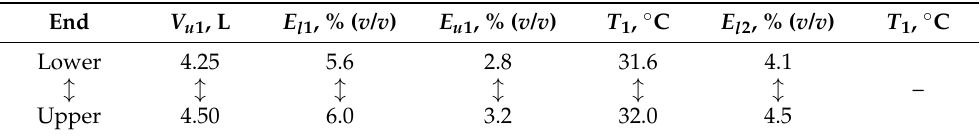
Table 3. Upper and lower end of the ranges over which the operational variables maximized ( r A ) global est .